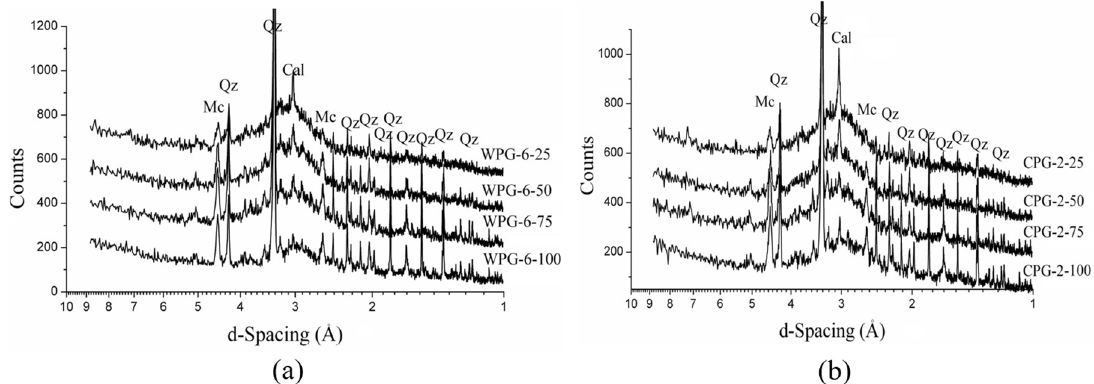
Figure 9. X-ray diffraction pattern of geopolymers with (a) 25, 50, 75 and 100% WP-6, (b) 25, 50, 75 and 100% CP-2, where Mc is 1M muscovite with PDF no 021-0993, Qz is quartz 046-1045 and Cal is calcite 005-0586.